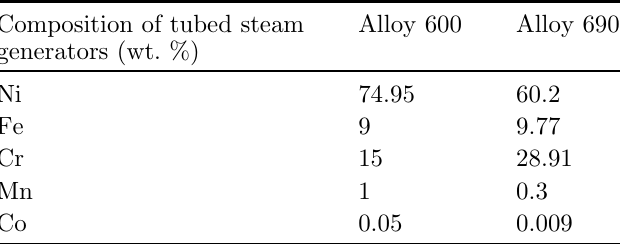
Table 1. Weight composition of alloy 600 and 690 tubed steam generators. Composition of tubed steam generators (wt. %)